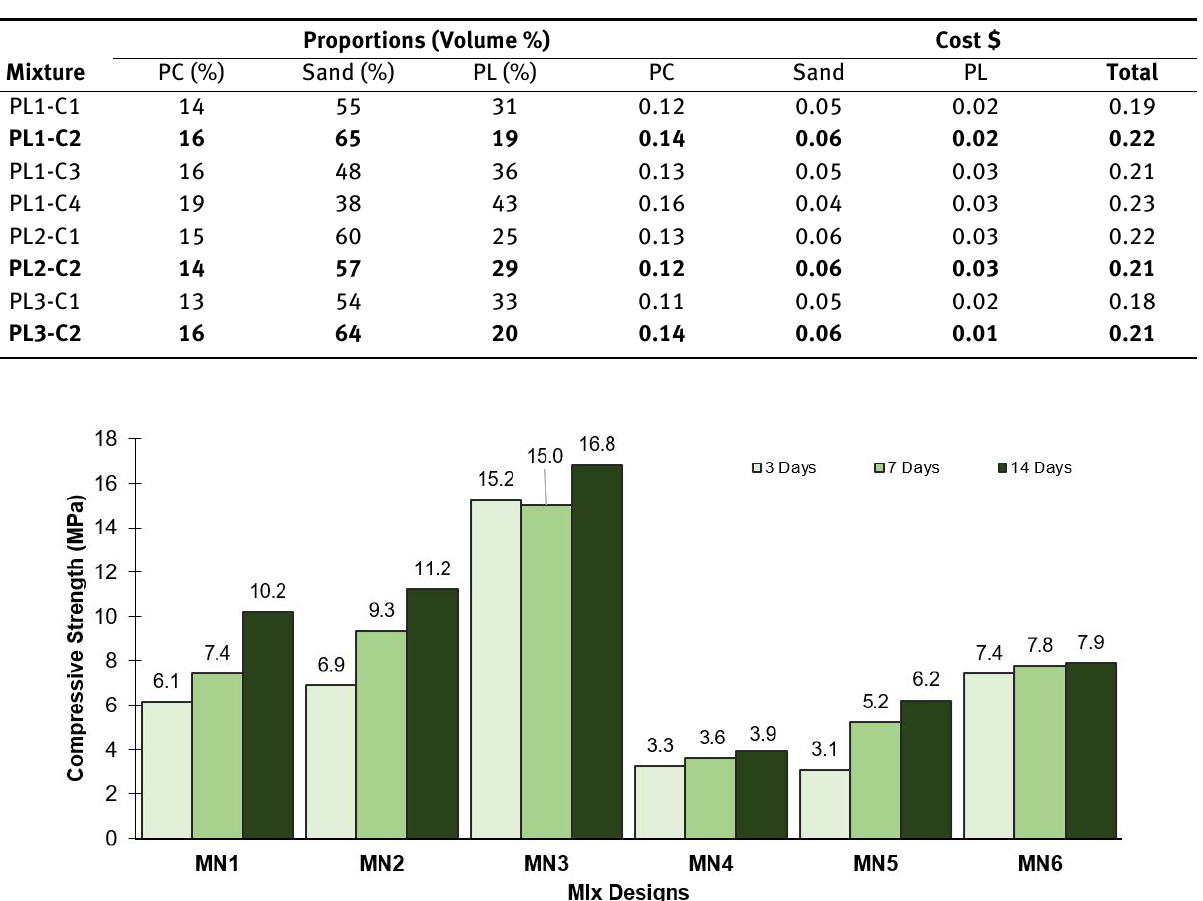
Table 5: Volume percent and summary of cost for the Eco-Bricks